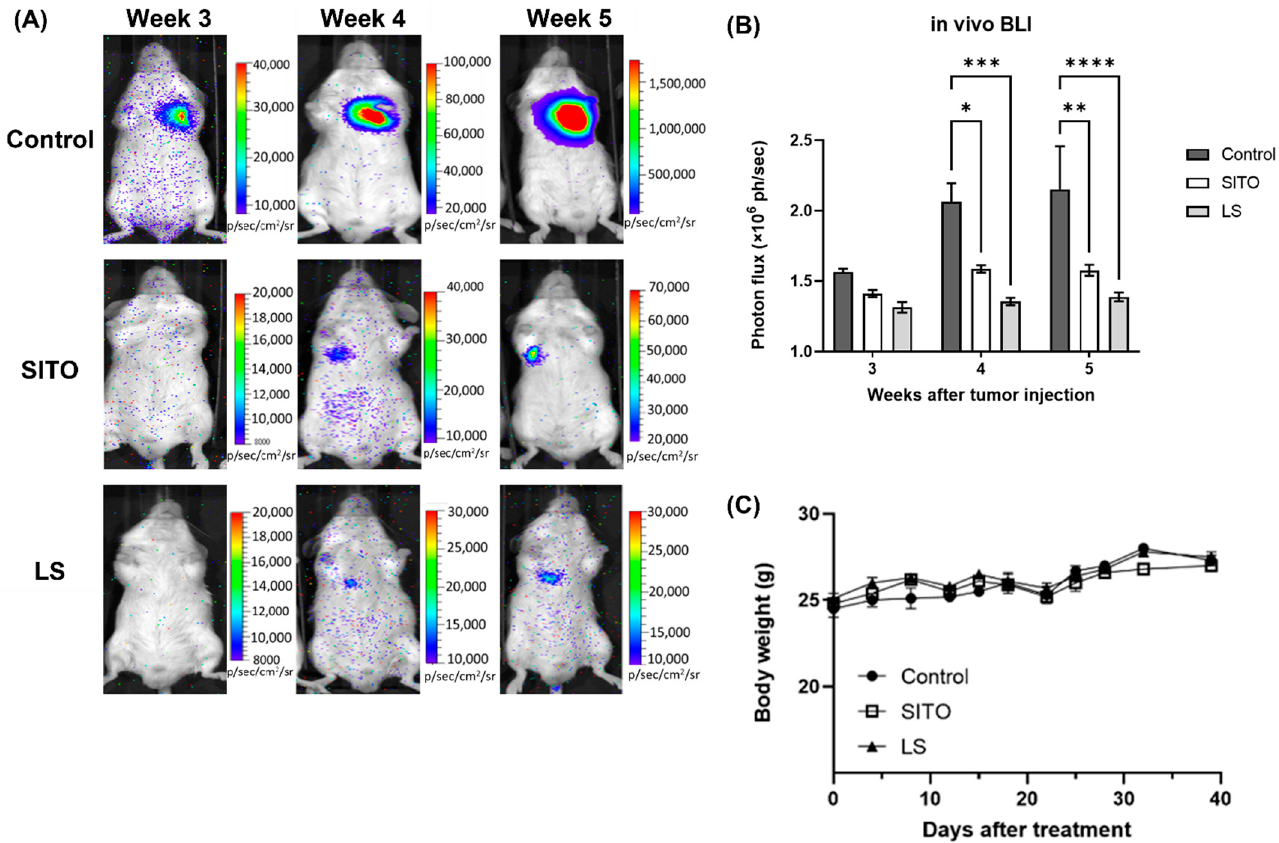
Figure 3. BLI showed the tumor progression in vivo. ( A ) BLI monitored the progression of lung metastasis noninvasively in mice receiving different treatments in vivo. ( B ) The quantitative results of BLI demonstrated that the SITO and liposomal β -sitosterol (LS) groups showed better tumor suppressions compared with that of the Control group from week 3 to week 5 after cell injection. ( C ) The body weight monitoring post-treatments up to 40 days. The body weight changes were within 20% among the three groups, suggesting no general toxicity post-SITO or LS treatments. Each point represents the means ± SE. ( * p < 0.05, ** p < 0.01, *** p < 0.001, and **** p < 0.0001). Ex vivo BLI was performed on 11 different tissues and organs excised from each mouse after the final in vivo BLI on week 6 (Figure 5). Only the tissues or organs derived from the